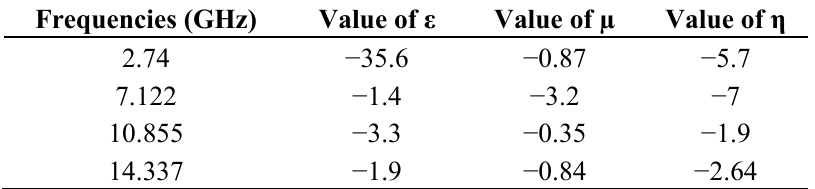
Table 2. Real values of ε, µ and η at the desired resonance frequencies for the unit cell. Frequencies (GHz) Value of ε Value of